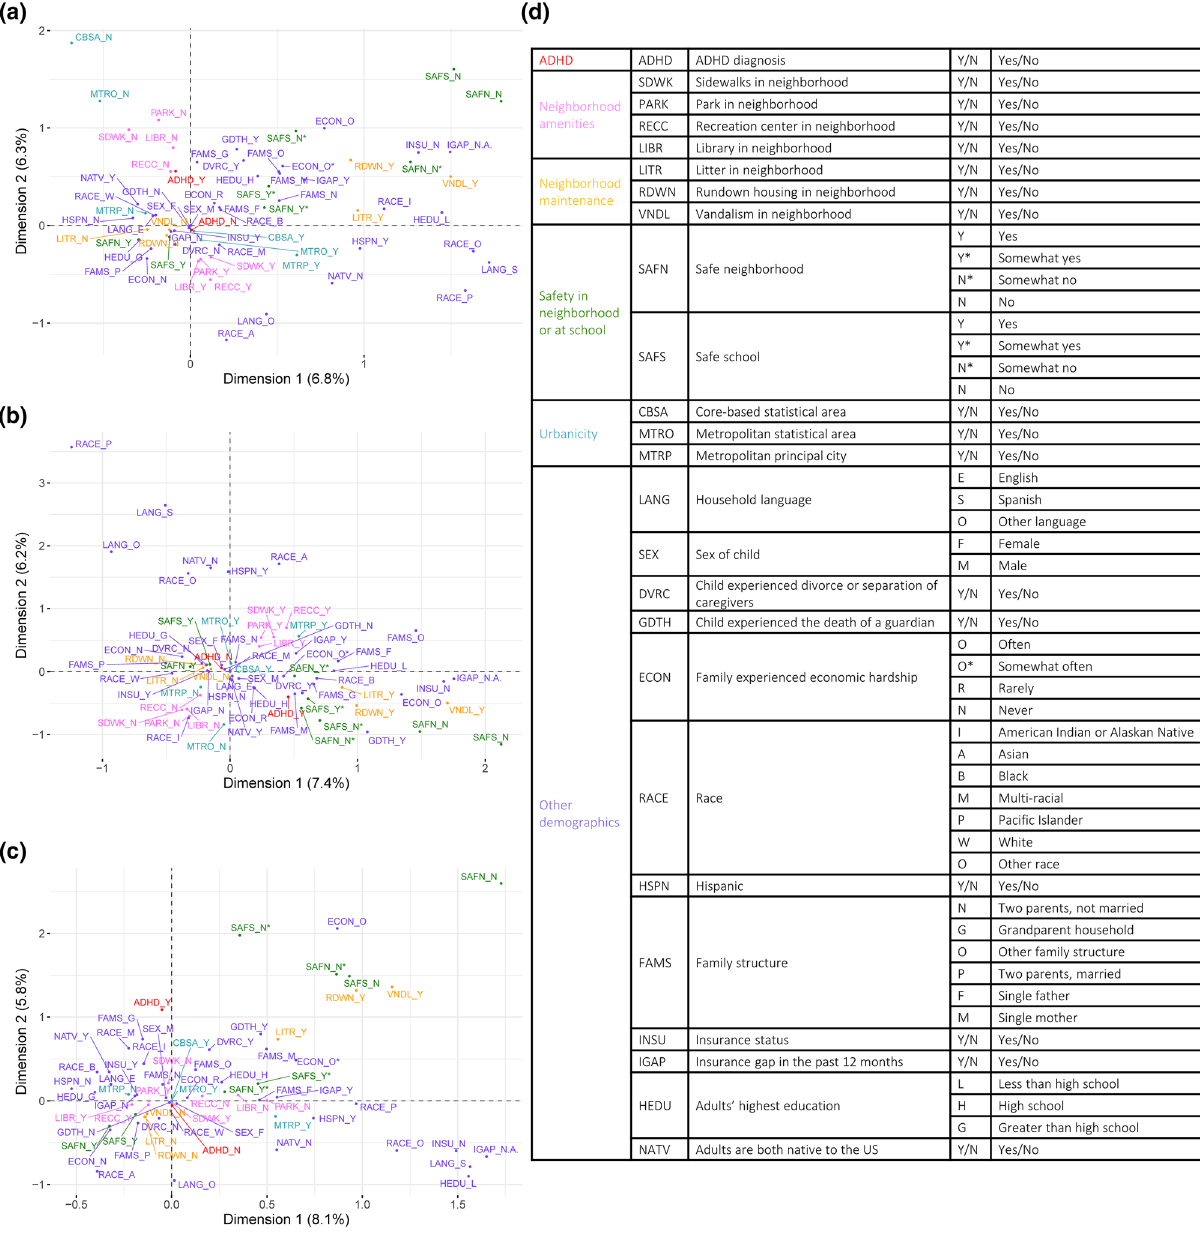
Figure 3. MCAs of ADHD diagnosis, SES factors, and demographics for samples ( a ) nationwide (n = 59,445), ( b ) from Louisiana (n = 1,255), and ( c ) from Nevada (n = 1,154). Data were collected from the NSCH 2018 and 2019 individual responses, and missing responses were imputed using the regularized iterative MCA algorithm of the missMDA R package. ( a – c ) MCA plots display associations between variables, with more closely associated variables displayed closer together. For instance, in panel A, ADHD_N and CBSA_Y are closely associated, but CBSA_N and Race_P are not. Positive diagnosis (ADHD_Y) and lack of diagnosis (ADHD_N) are shown in red. The percent variance retained is indicated for each dimension. ( d ) Table of all variables analyzed, with their possible responses and None of the national, LA, or NV MCAs indicate a relationship with ADHD diagnosis for parental nativity or Hispanic ethnicity (Fig. 4a–c). In all three analyses, unsafe school, unsafe neighborhood, and economic hardship are associated with ADHD diagnosis, while safe school and neighborhood, no economic hardship, two married parents, a household language besides English, no guardian’s death, and no parental divorce or separation are associated with a lack of ADHD diagnosis. All three MCAs display no guardian’s death and no parental divorce or separation in close proximity to a lack of ADHD diagnosis; NV data distribution does not display these adverse experiences near to the positive ADHD diagnosis, although both national and LA MCAs do. MCA reveals the lack of ADHD diagnosis associated with Asian and multi-racial children in the national dataset, Pacific Islander, White, multi-racial, and other children in LA, and White and Asian children in NV. In